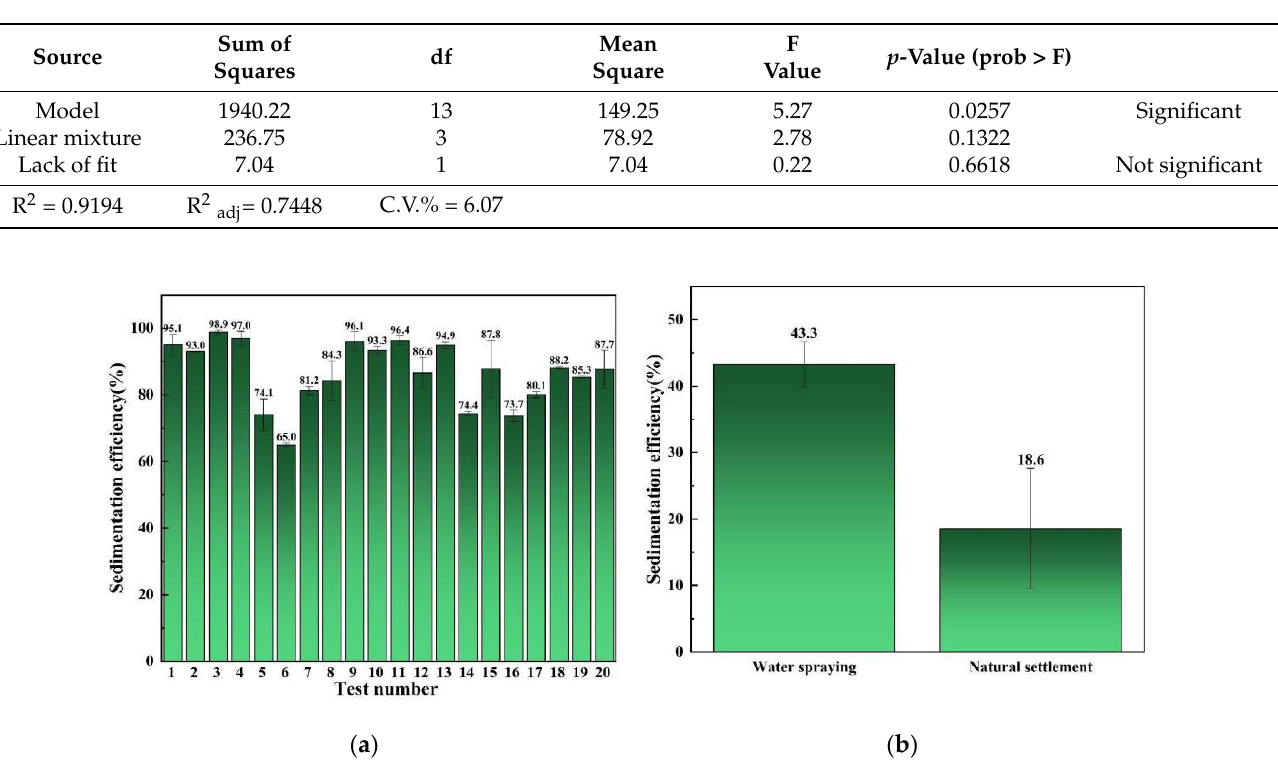
Table 1. ANOVA analysis of variables tables.